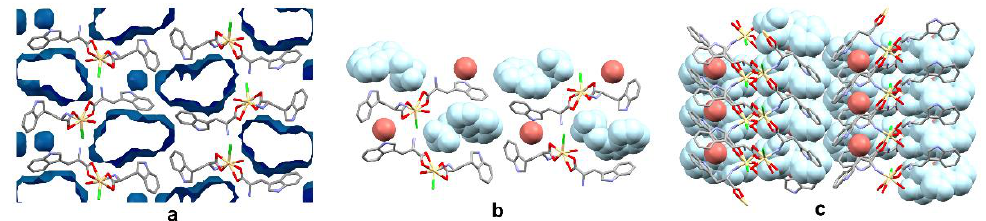
Figure 4. ( a ) The visualization of the channels and the pockets occupied by the tryptophan and water molecules in the studied crystal. Void volumes are based on the contact surface as calculated by Mercury, with a grid step of 0.7 Å and a probe radius of 1.2 Å; the visualization of the assembly of the guest water (red) and the Trp (light blue) molecules entrapped between the polymeric chains. View ( b ) along the a axis and ( c ) b axis. Hydrogen atoms are omitted for clarity.